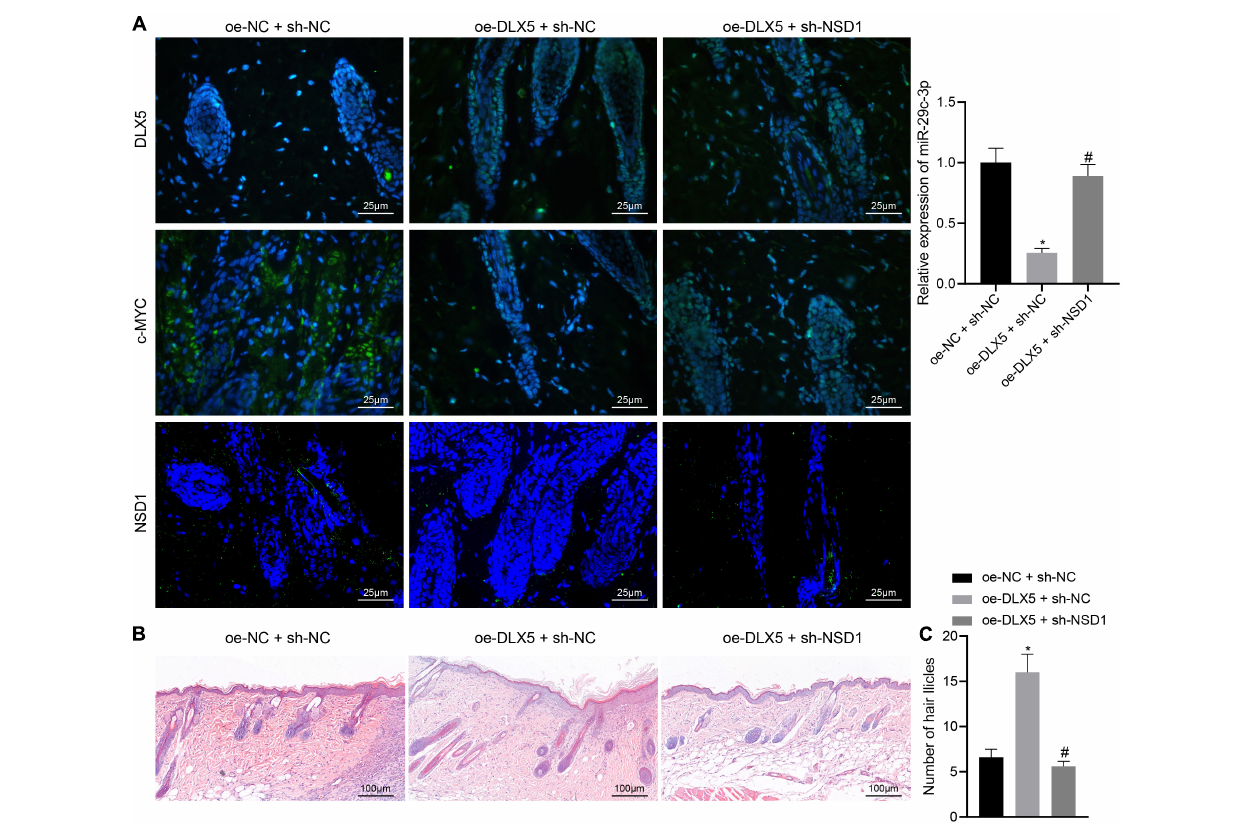
FIGURE 7 | DLX5 facilitates the hair follicle regeneration by regulating the c-MYC/miR-29c-3p/NSD1 signaling axis. (A) Expression of DLX5, c-MYC, and NSD1 determined by immunofluorescence assay in the back skin tissues of mice treated with oe-DLX5, sh-NSD1 or both (left panel); RT-qPCR analysis of miR-29c-3p expression in different group of the skin (right panel). (B) HE staining of back skin tissues of mice treated with oe-DLX5, sh-NSD1 or both after transplantation for 3 weeks ( × 400). (C) Counting of the hair follicle like structure of back skin tissues of mice treated with oe-DLX5, sh-NSD1 or both after transplantation for 3 weeks. * p < 0.05 compared with treatment of oe-NC + sh-NC; # p < 0.05 compared with treatment of oe-DLX5 + sh-NC. The data were expressed as mean ± standard deviation. Comparisons among multiple groups were performed using one-way ANOVA and Tukey’s test. N = 5 for mice following each treatment.